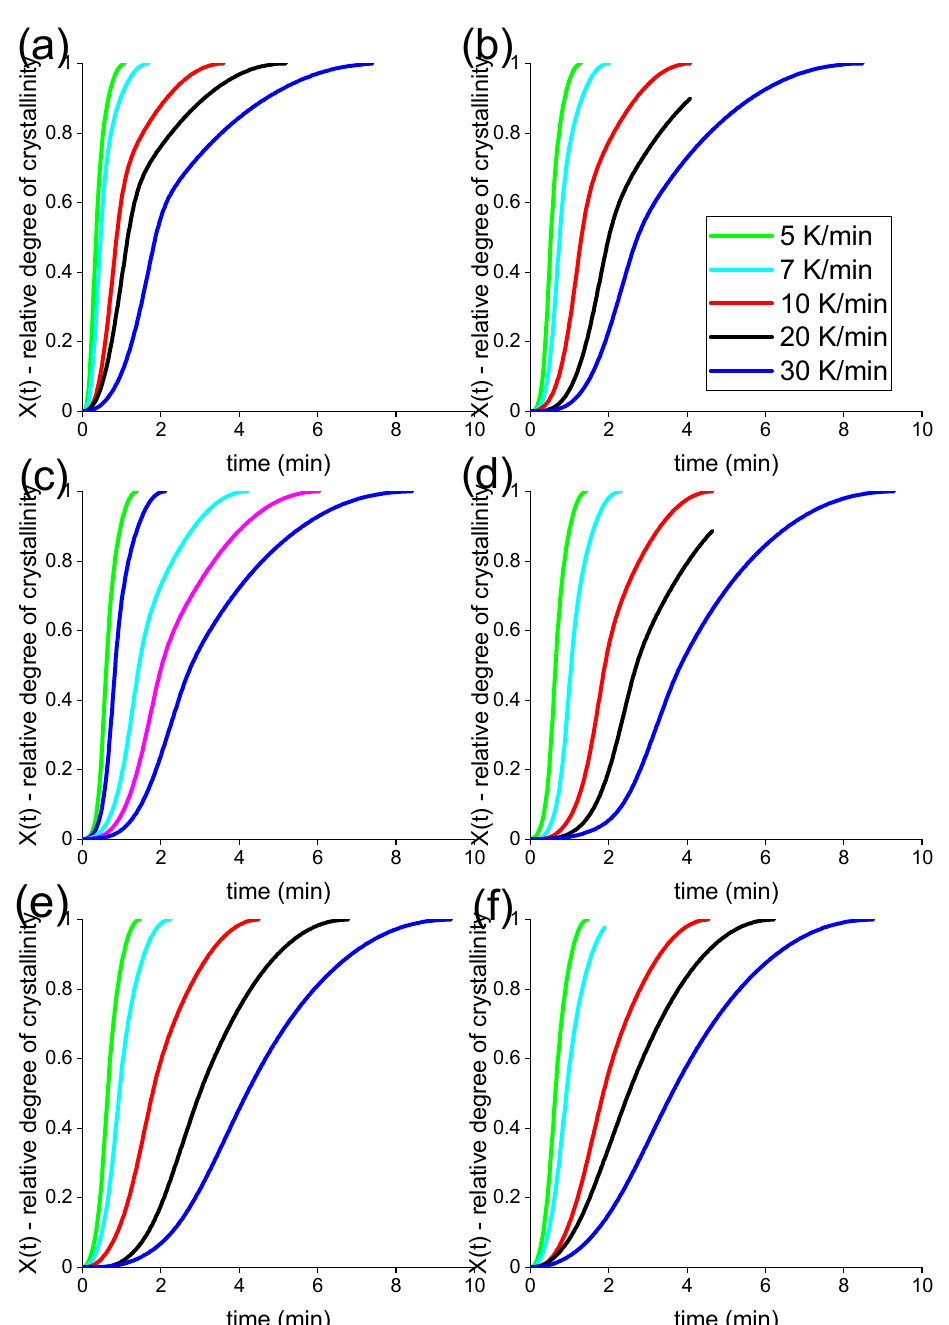
Figure 8. Relative crystallinity as a function of time for pure EVA20 ( a ) and its CB-based composites with loadings of 1.7 vol% ( b ), 4.5 vol% ( c ), 11.5 vol% ( d ), 21.2 vol% ( e ) and 25.8 vol% ( f ) at cooling rates between 5 K/min and 30 K/min.